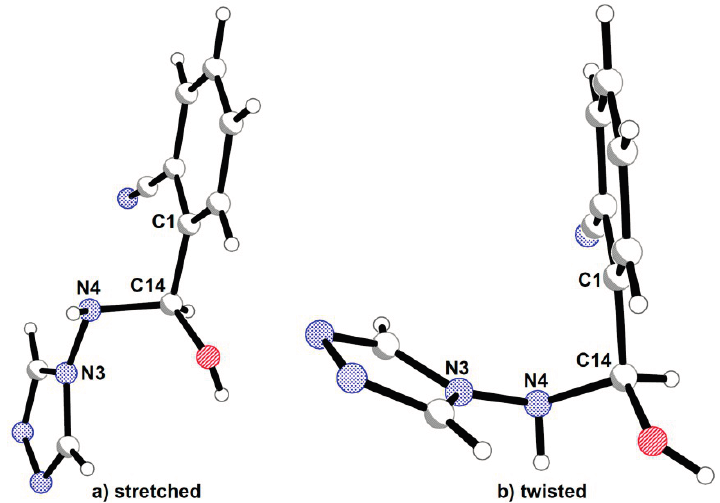
Figure 3. ( a ) Stretched and ( b ) twisted conformer of a